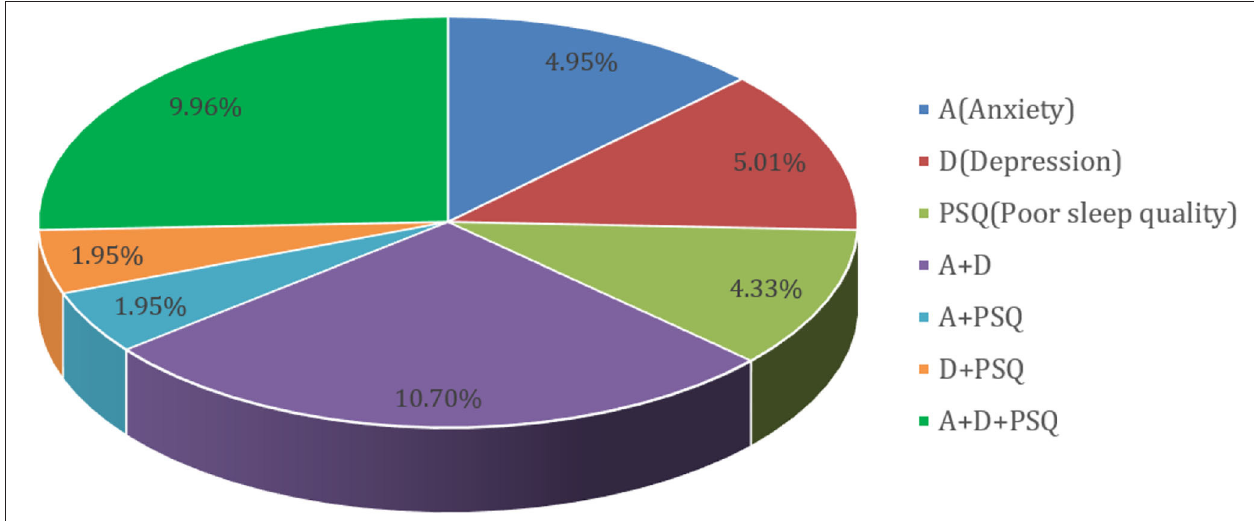
FIGURE 1 | Prevalence rate of probable anxiety symptoms, depressive symptoms and poor sleep quality ( N =